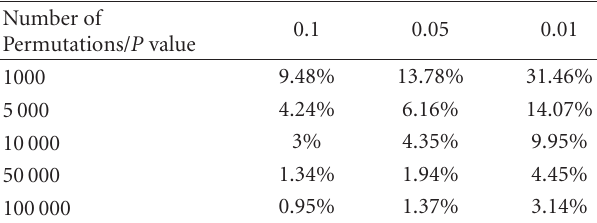
Table 1: Relative standard deviation of the desired P value, as function of desired P value and number of